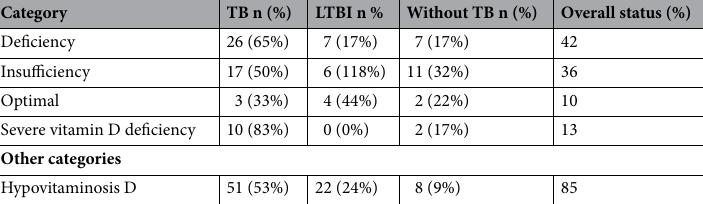
Table 3. Vitamin D status in study participants with TB, latent TB, and without TB infection. Severe vitamin D levels < 10 ng/ml vitamin D deficiency < 20 ng/ml insufficiency = 21–29 ng/ml and optimal levels = ≥ 30 ng/ ml.